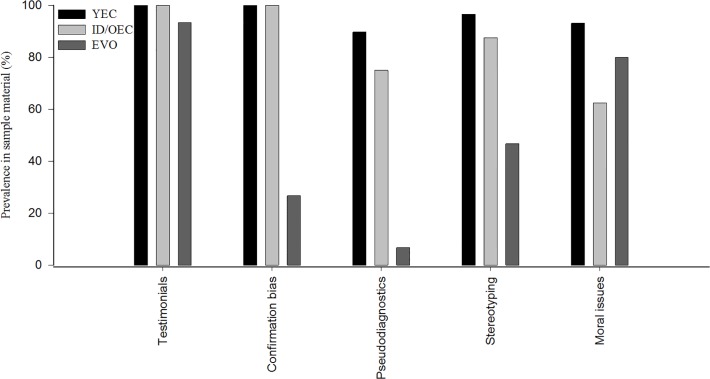
Prevalences (%) of selected aspects of experiential thinking in the sampled material representing young-earth creationism (YEC; n = 29), intelligent design/old-earth creationism (ID/OEC; n = 8) and pro-evolutionary texts (EVO; n = 15).“Testimonials” include personal testimonies, quotes, appeals to authorities, etc. “Confirmation bias” represents ignoring or dismissing contradictory data and alternative hypotheses. “Pseudodiagnostics” entails giving high relevance to misinterpreted or irrelevant issues. “Stereotyping” includes dichotomies and generalizations and “moral issues” refer to scientifically irrelevant discussion of moral implications to prove or disprove a claim. * = Difference between the text types (χ2-test, Fisher’s exact test, p < 0.001).